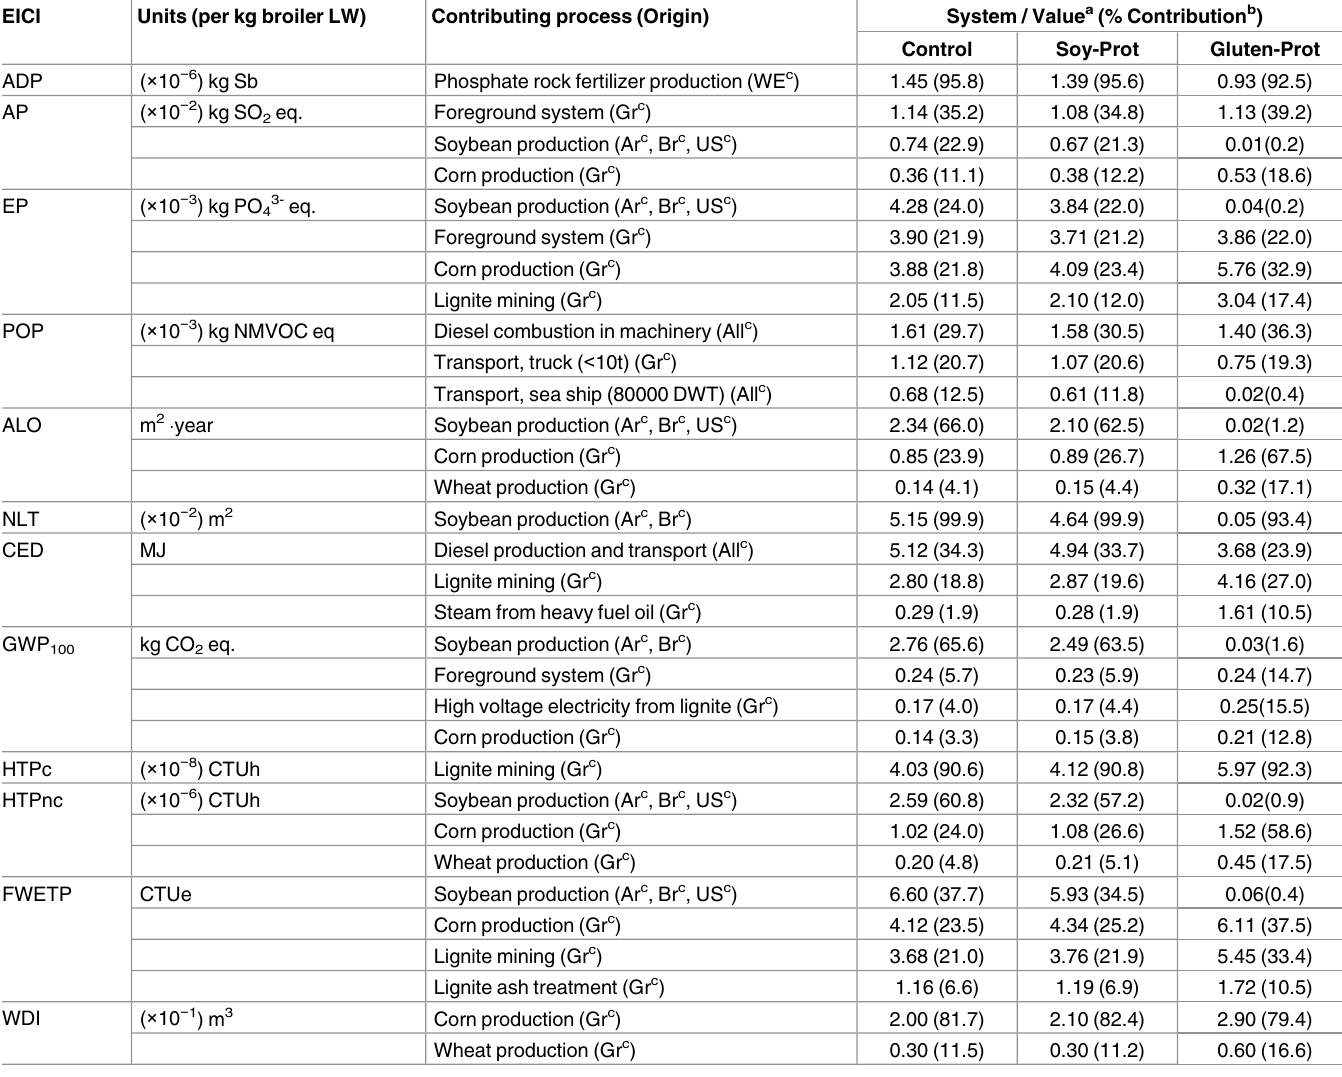
Table 12. Major contributing processes( (cid:21) 10%contribution) and their potential contribution to the total environmental impact category indicator (EICI) values for the three systemsstudied. EICI Units (per kg broiler